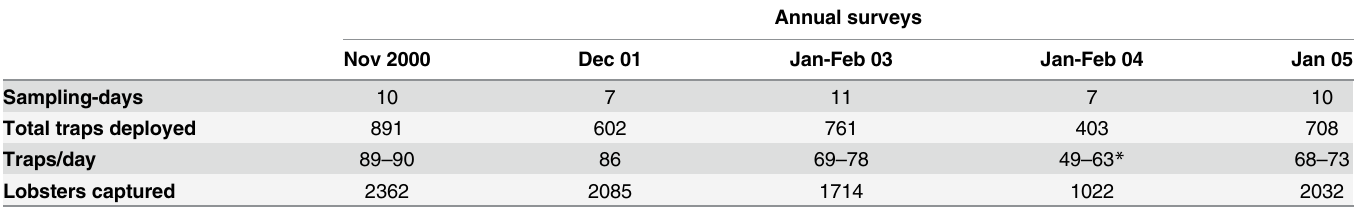
Table 1. Summary of sampling